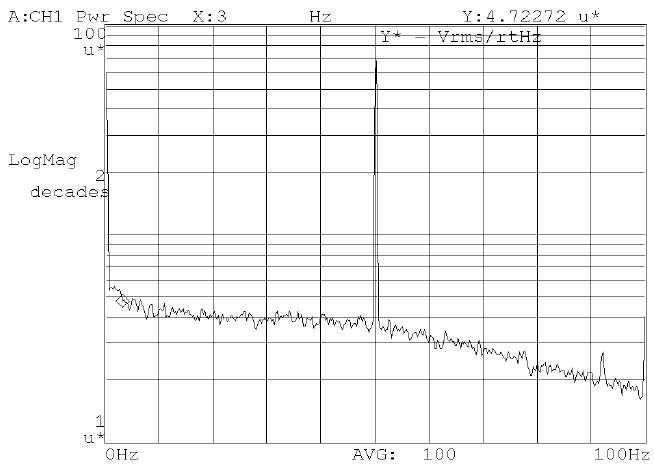
Figure 15. Zero-point output noise.